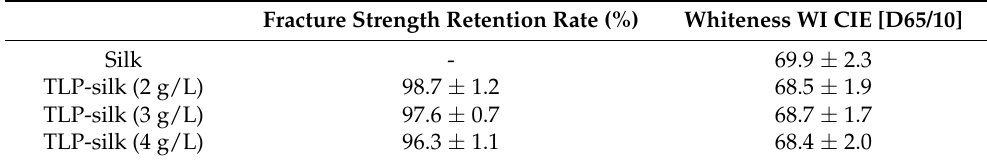
Table 3. Fracture strength retention rate and whiteness of finished and control silk.